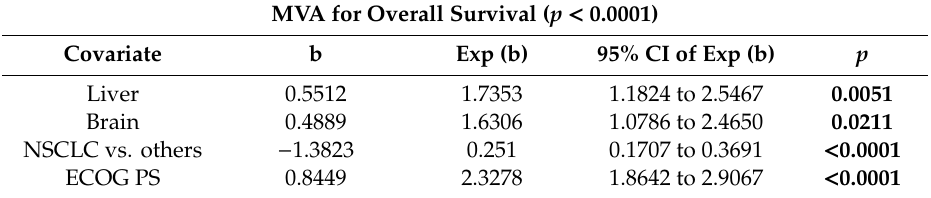
Table 5. Multivariate analysis for